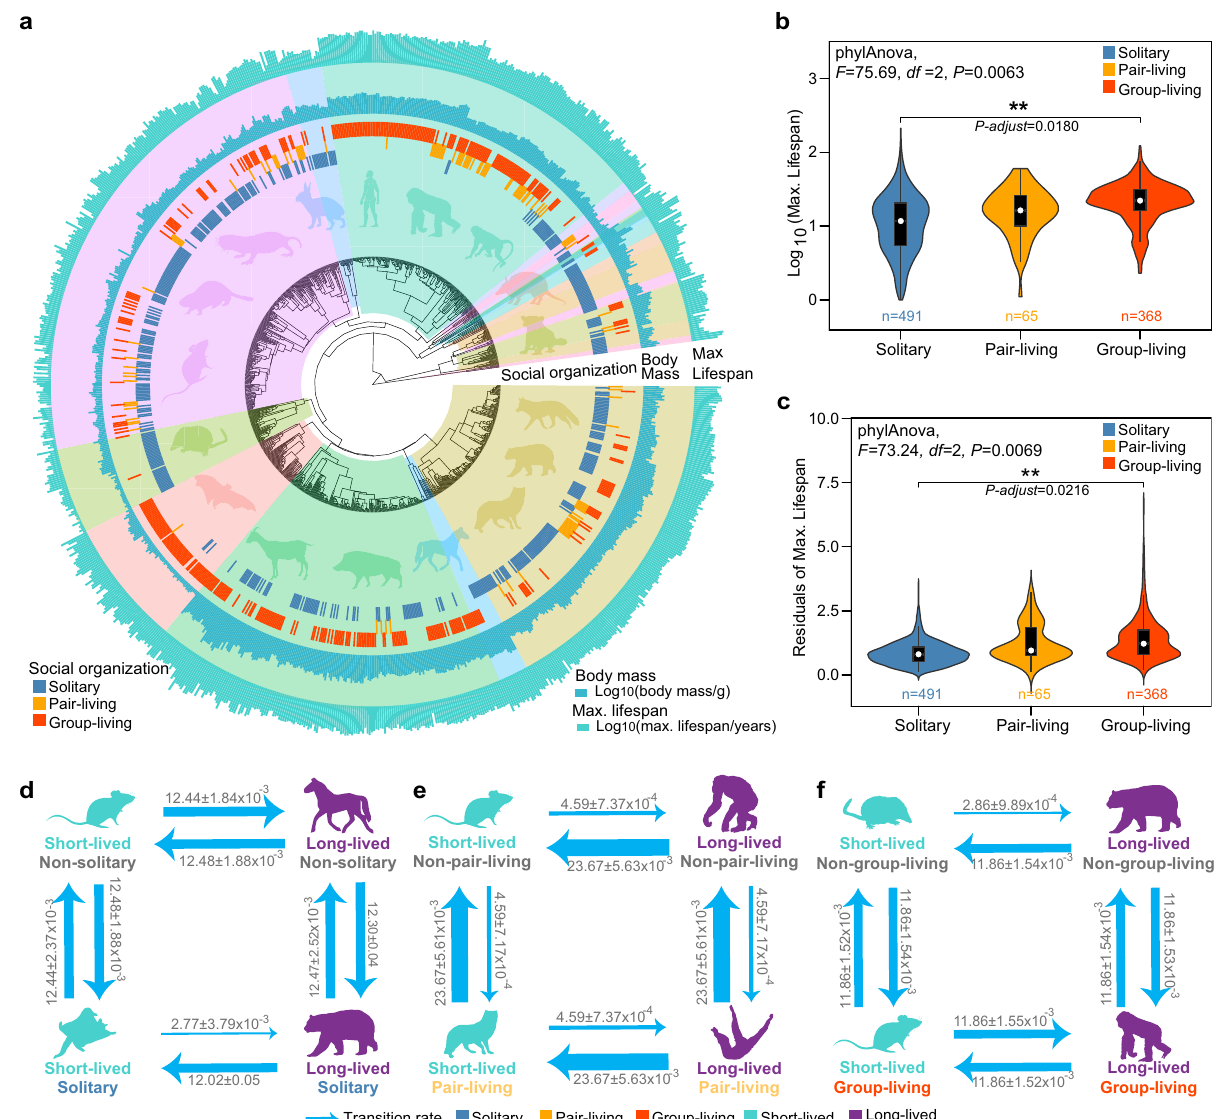
Fig. 1 | Evolutionary analyses of social organization and longevity in 974 mammalianspecies.a Phylogeneticdistributionofsocialorganization,adultbody mass, and longevity ( n =974). The inner circle represents a species ’ social organi- zation:solitary(blue),pair-living (orange),and group-living (red).The middlelayer indicates the absolute adult body mass (g) and the outer layer indicates the long- evity(years);bothvariableswerelog 10 transformed.Colorsofshadingsdistinguish different mammals ’ orders. b Difference in absolute longevity and c relative long- evity (residuals of longevity, which was adjusted for body mass) across the three socialorganizationstates(solitary: n =491,pair-living: n =65,group-living: n =368). We accounted for the effects of phylogenetic non-independence among species using a Phylogenetic ANOVA. Two-sided and Hommel method adjust P values are reported. The white dot represents the median in two violin plots, and the black